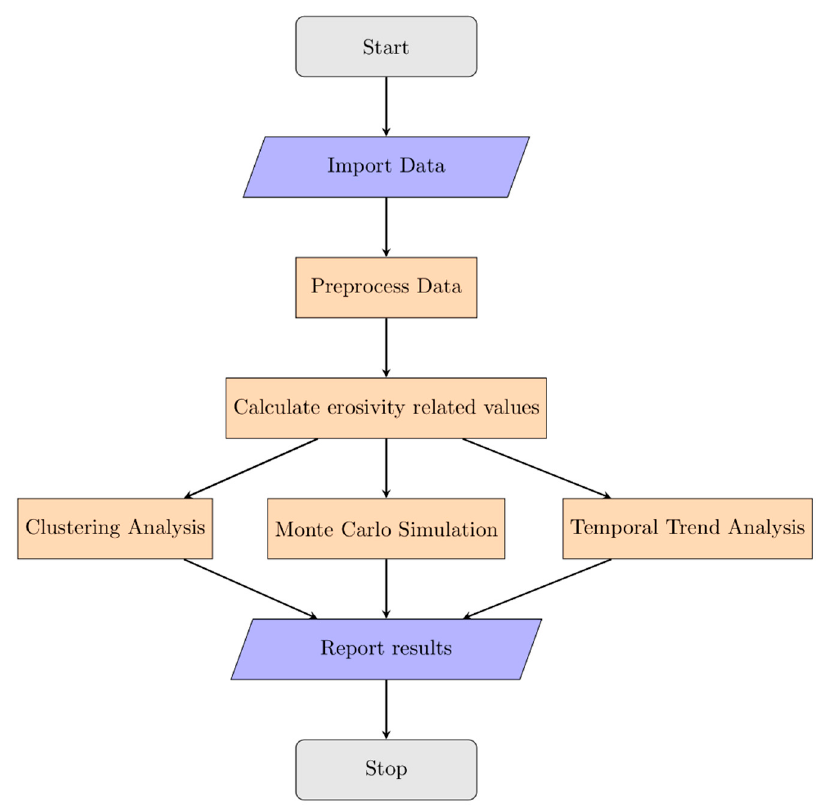
Figure 1. Flowchart of the applied methodology.